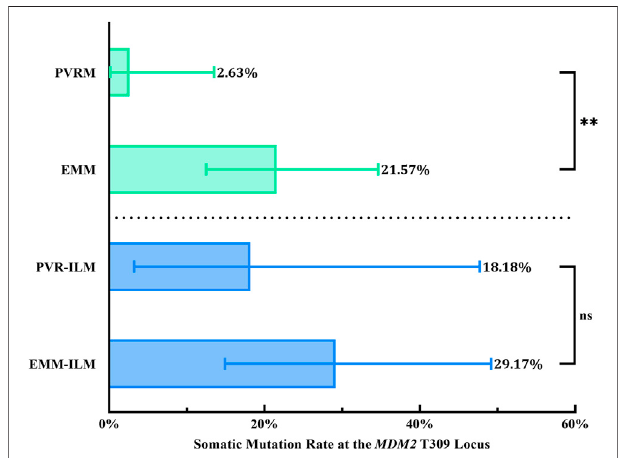
FIGURE6| Somaticmutationatthe MDM2 T309Glocusinmembranes. EMMs were prone toward somatic mutation at the MDM2 T309G locus, in contrast to PVRMs. PVR-ILMs and EMM-ILMs showed comparable mutation rates. 95% CI, 95% con fi dence interval; EMM, epimacular membrane; ILM,internallimitingmembrane;MDM2,mousedoubleminute2gene;ns,not signi fi cant; PVRM, proliferative vitreoretinopathy membrane. Asterisks indicate statistical signi fi cance upon comparison: ** p < 0.01. Data are presented as the somatic mutation rate at the MDM2 T309G locus ±95% CI.